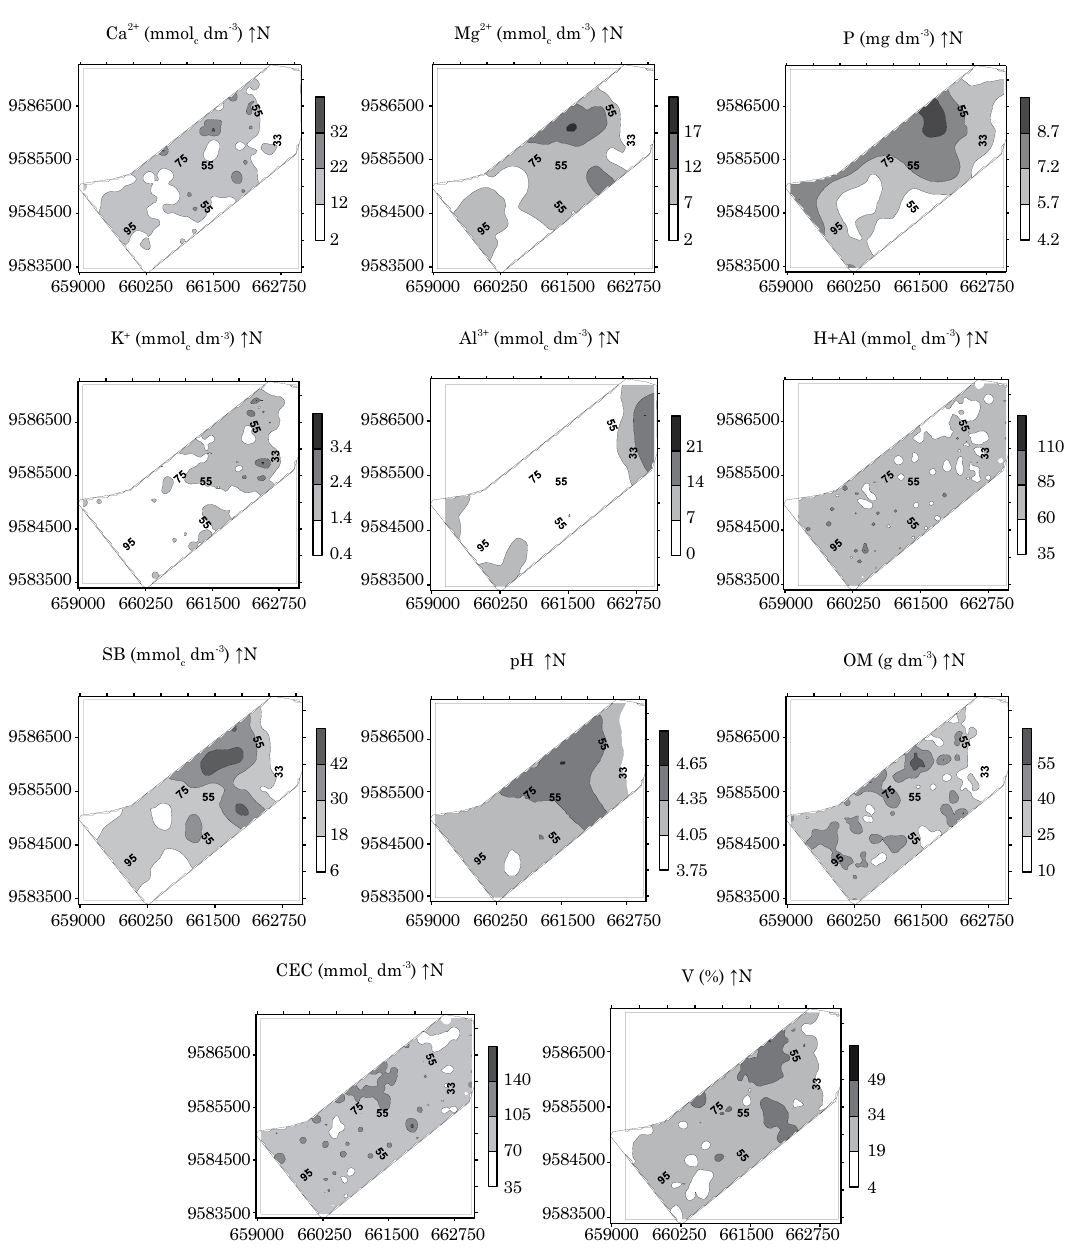
figure 3. Spatial pattern maps for soil chemical variables in the agrarian reform